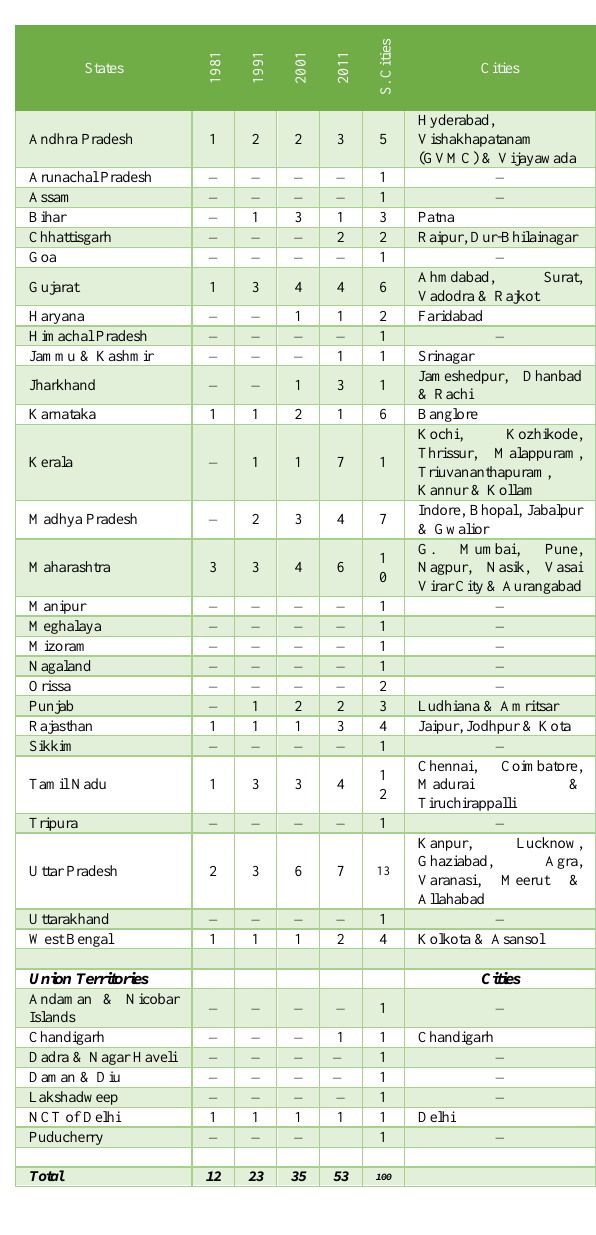
Table 5. State-wise Distribution of Cities and Mega Cities in India: 1981 to